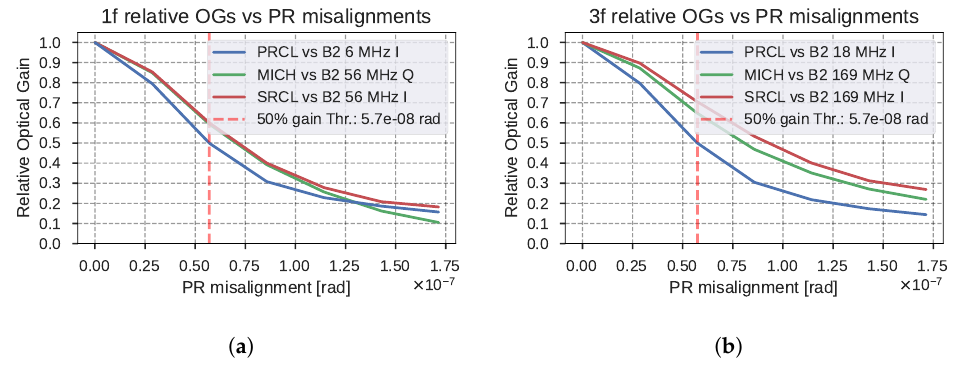
Figure 9. DRMI error signals Optical Gain (OG) variation vs. misalignments of the PR mirror. Each line corresponds to the relative optical gain of an error signal used to control the DRMI. ( a ) shows the “1f” error signals; ( b ) shows the “3f” error signals. The OGs are relative to the gains in a fully aligned condition. The vertical line marks the lowest angle at which one of the error signals has lost 50% of its